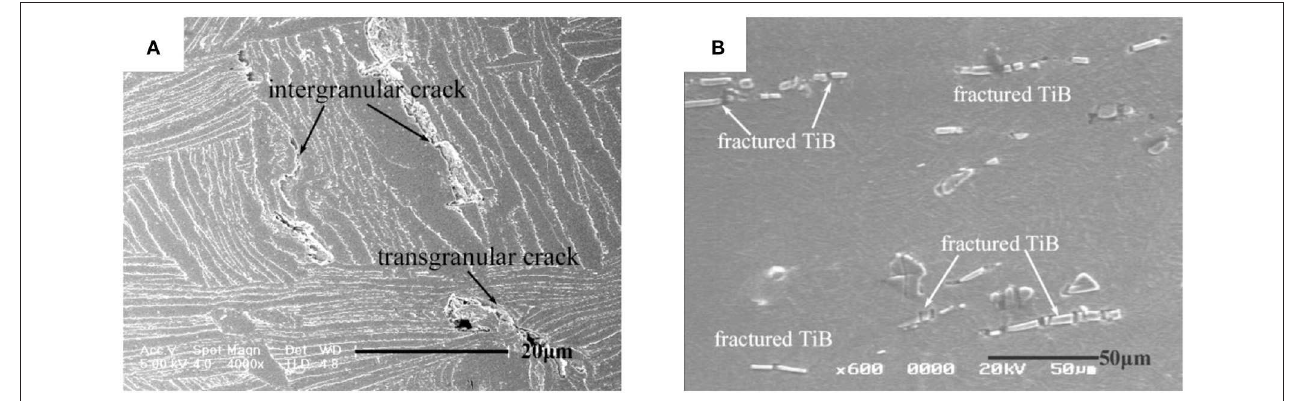
FIGURE 6 | SEM images of matrix alloy and TMCs near fracture surfaces after 923K temperature tensile test. (A) Matrix alloy after HT1. (B) TMCs after HT2.